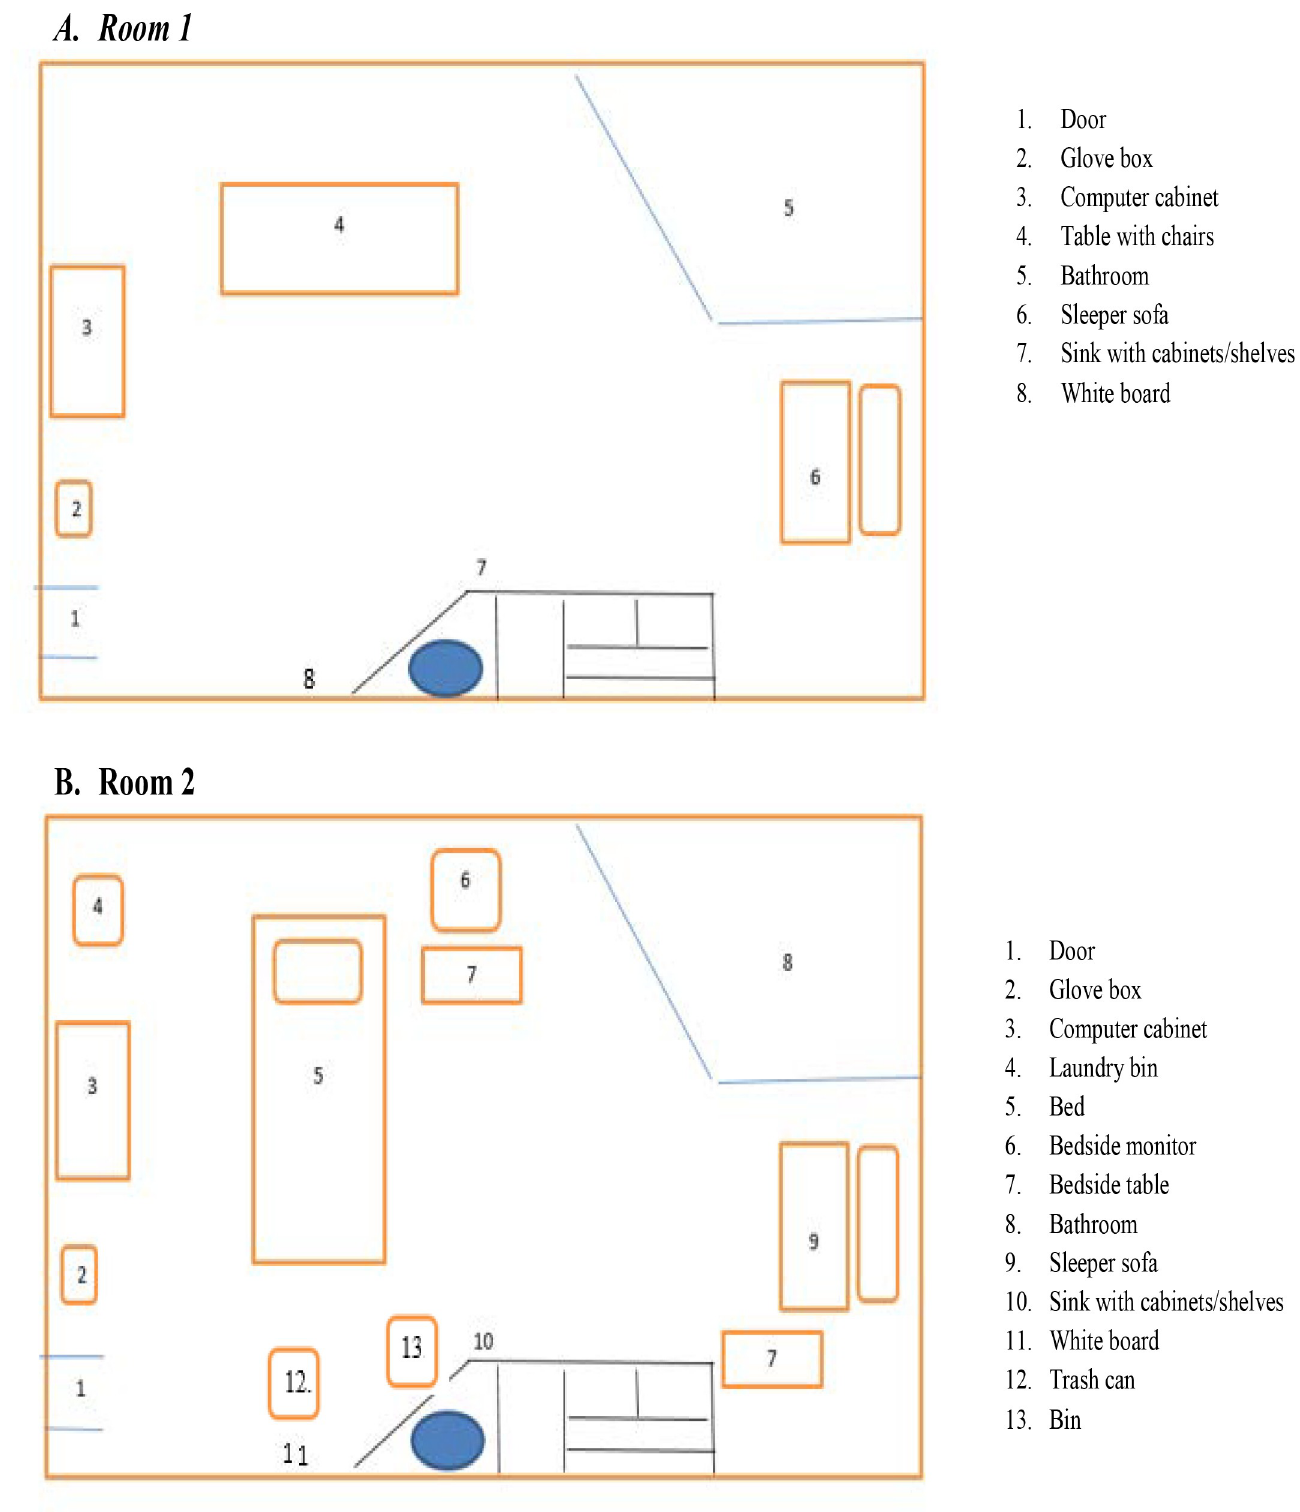
Fig 1. Simulated workplace setting, two single occupancy hospital rooms.